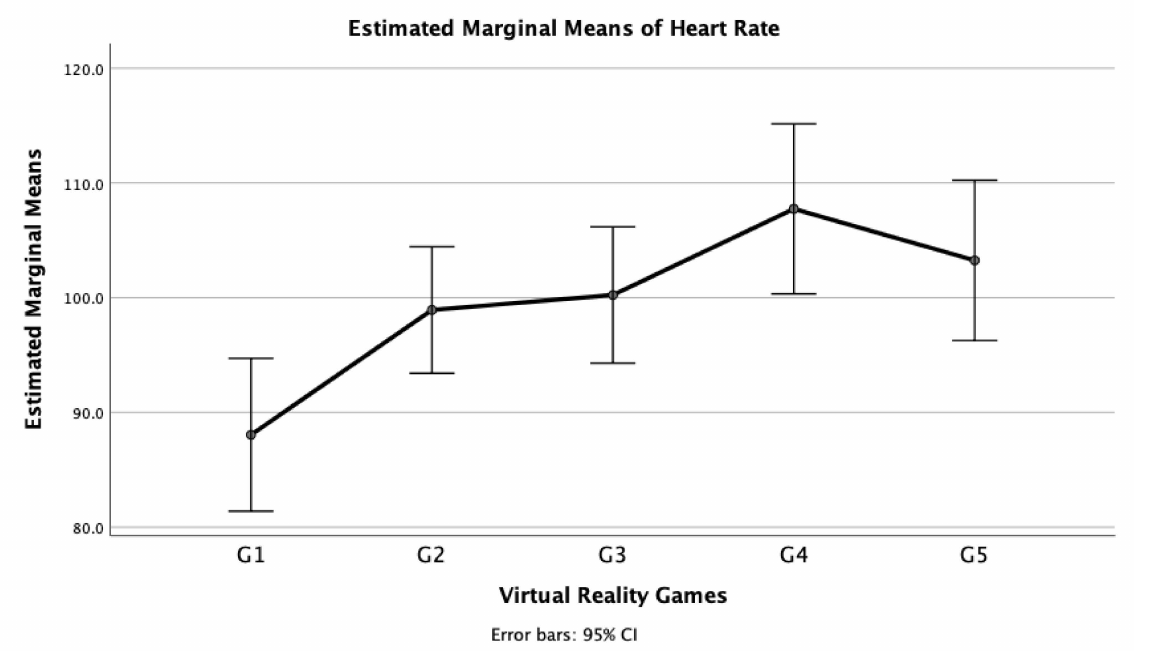
Figure 2. Variation in games’ heart rate across a complete rehabilitation session to recover from musculoskeletal